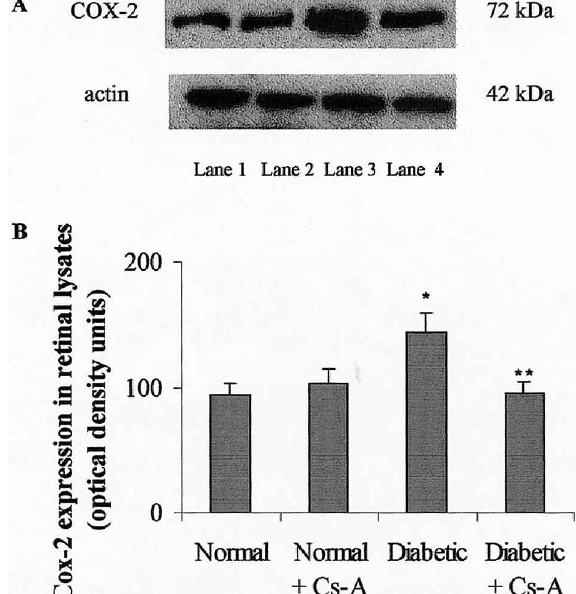
FIG. 5. Study of the expression of COX-2 protein. (A) Western blot for detection of COX-2 protein expression in retina. Lane 1: retinal lysate from normal rats; Lane 2: retinal lysate from Cs-A-treated normal rats; Lane 3: retinal lysate from diabetic rats; Lane 4: retinal lysate from diabetic rats. This figure is representative of 5 identical experiments. (B) Densitometric analysis of COX-2 expression. Anti-actin was used to ensure that the protein loading was equivalent. Data are mean ± SD values from 5 rats from each group. *Significant differences from normal rats. **Significant differences from Cs-A non- treated diabetic rats ( p < 0.05) (one-way ANOVA analysis, Dunnett’s test).